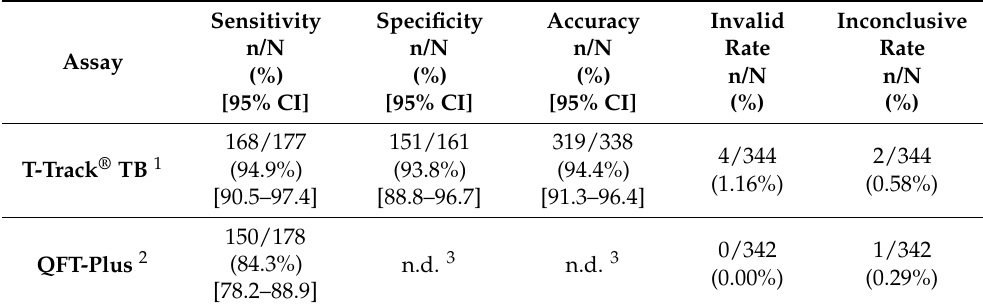
Table 2. Diagnostic performance of T-Track ® TB and QFT-Plus to discriminate active TB patients from non-infected